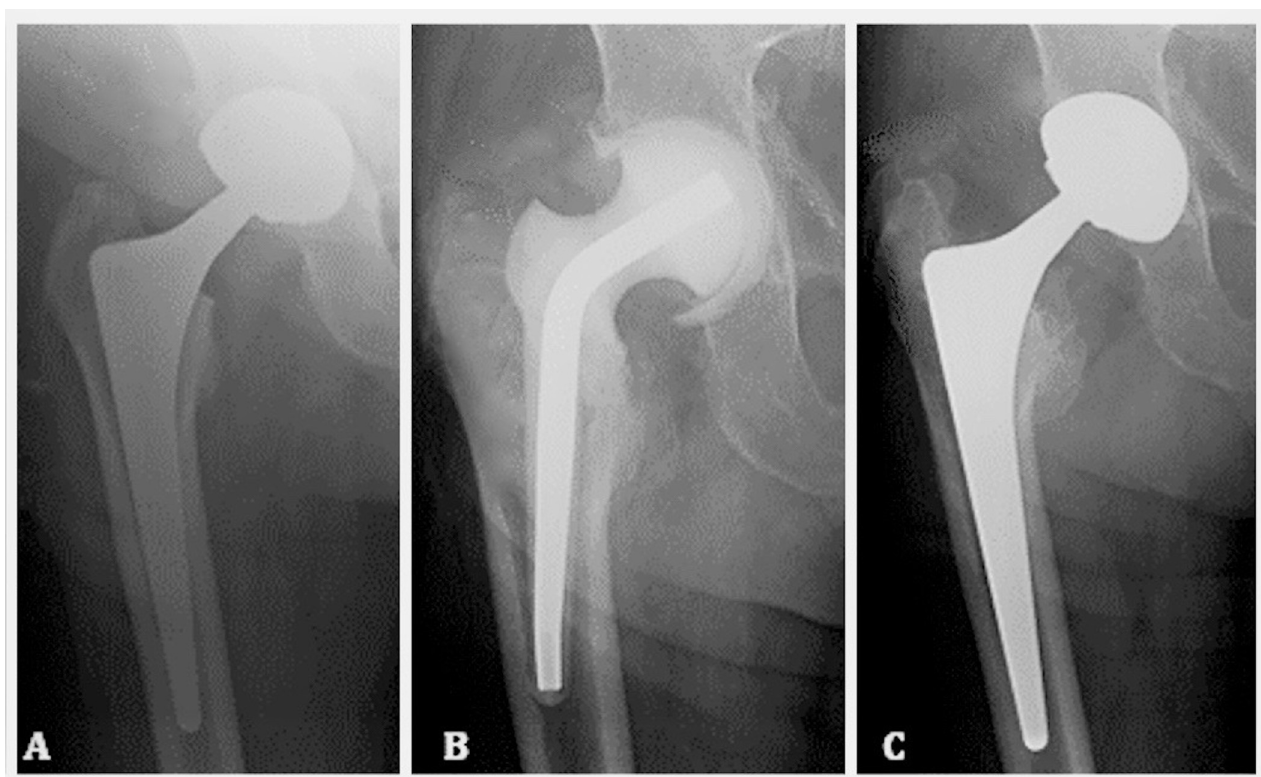
Fig 1. Radiographic example of two-stage revision for hip PJI with primary components. Pre-operative X-ray of infected THA (A), radiographic assessment of spacer placement 6 weeks after the explantation stage (B) and final assessment of completed two-stage procedure at 3 years (C).